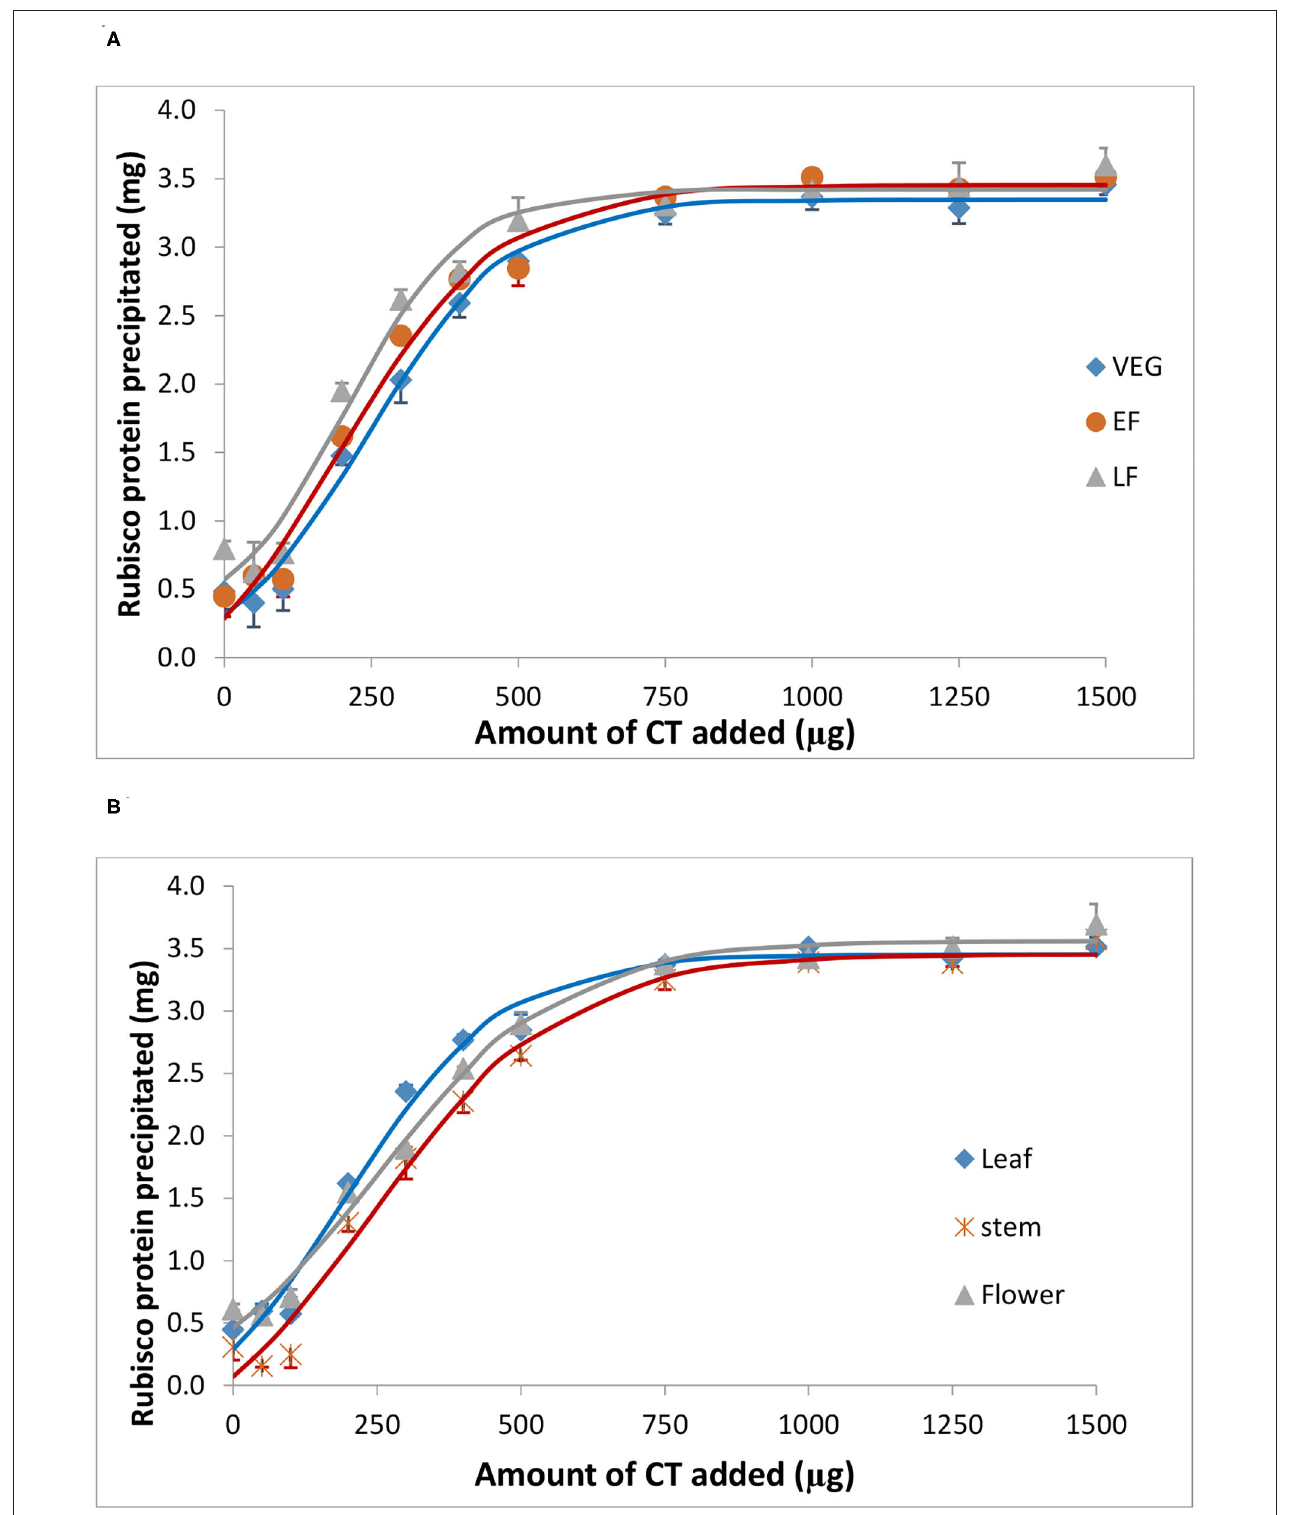
FIGURE 5 | Precipitation of spinach ribulose 1,5-disphosphate carboxylase (Rubisco) by CT isolated from the leaves of PPC ( Dalea purpurea Vent.) at VEG, EF, and LF growth stages (A) , and from leaves, stems, and flowering heads at the early flowering heads (B) . Lines relate to corresponding CT data which were fitted to a SigmaPlot curve as described under statistical analysis. Bars indicate SE and where not visible, fall within the symbols.